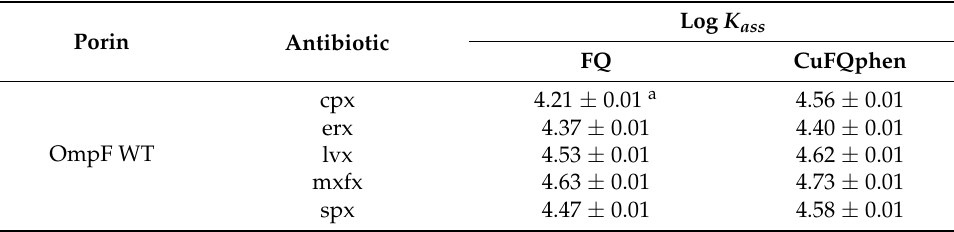
Table 2. Values of the association constants ( K ass ) of OmpF-compounds, determined with OmpF WT/E. coli total extract proteoliposomes, by steady-state fluorescence, using Equation (3). The pre- sented values are the mean of, at least, three independent experiments ( ±